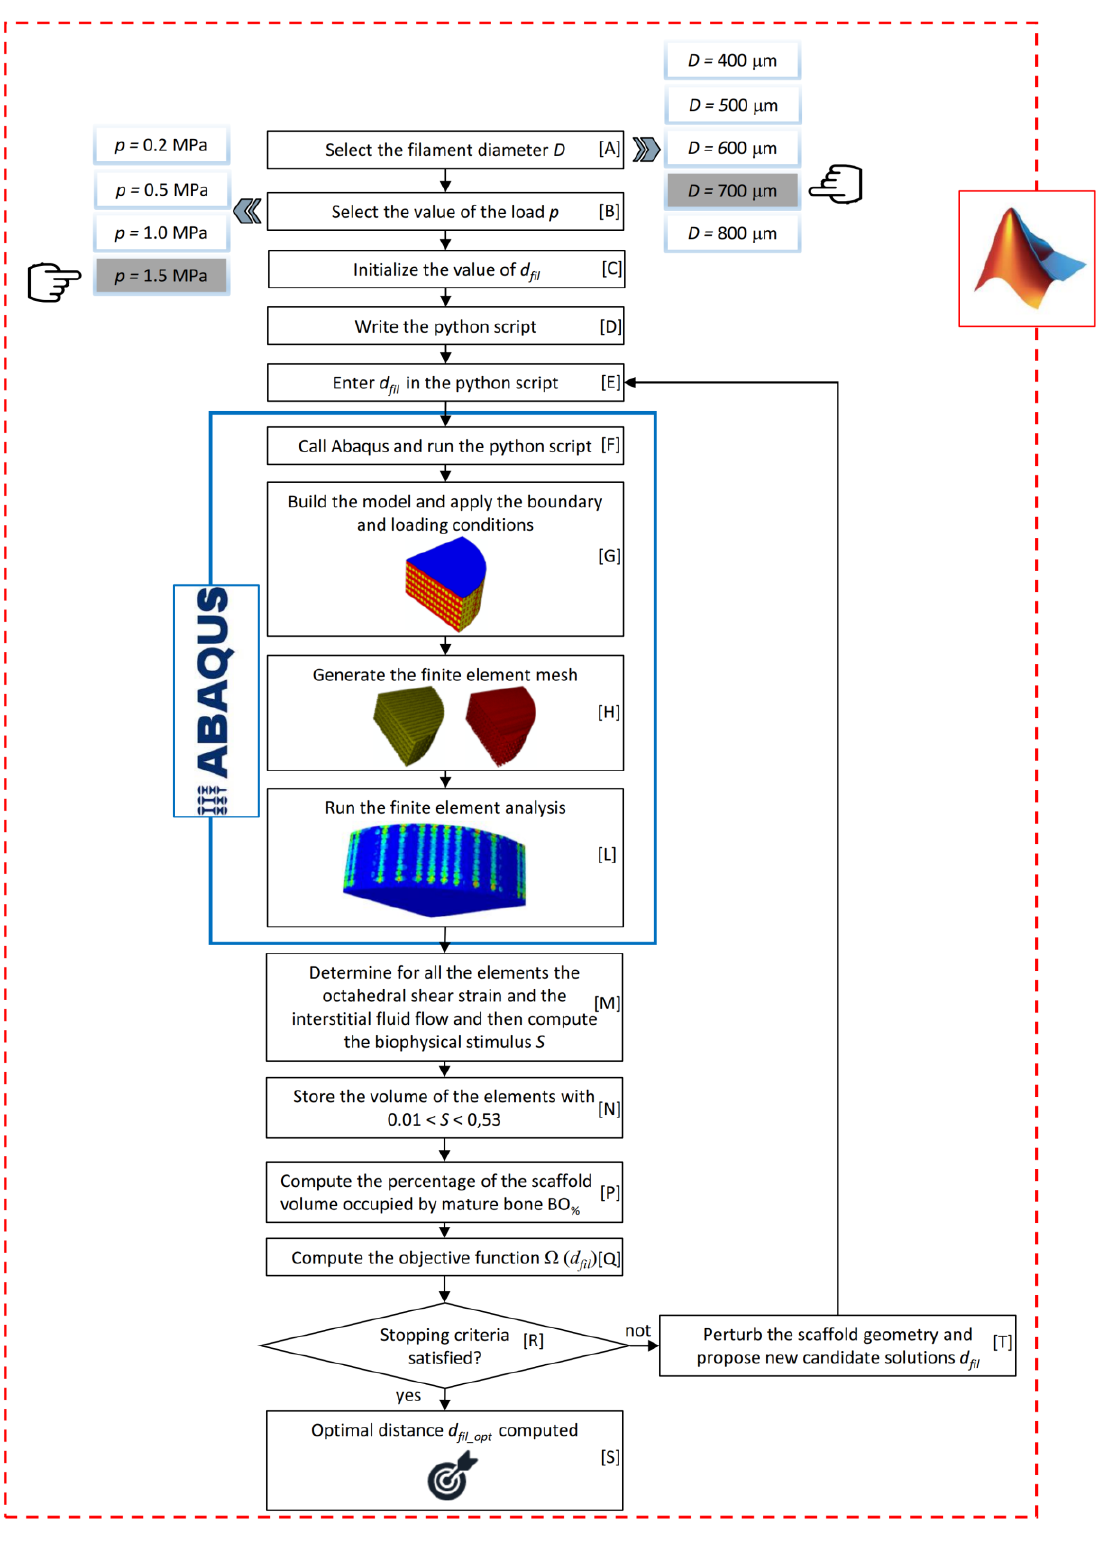
Figure 4. Schematic of the optimization algorithm written in MATLAB environment.